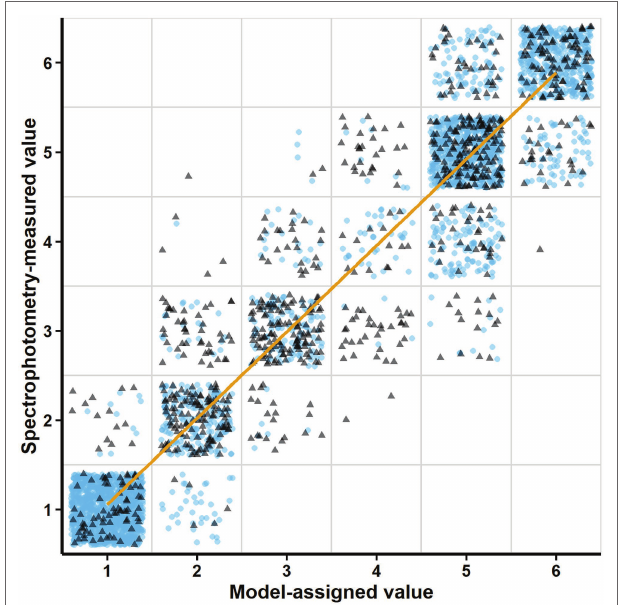
FIGURE 3 | Relationship between the Model-assigned values (density levels automatically assigned to the scanned images according to the trained model) and the Spectrophotometry-measured values (density levels assigned after spectrophotometric measurements). Blue circles correspond to the validation dataset (using horizontally flipped images of the training dataset). Gray triangles correspond to the test dataset (new images and spectrophotometric measurements). The trend line represents the linear regression fit ( R 2 = 0.95) between the assigned and the measured